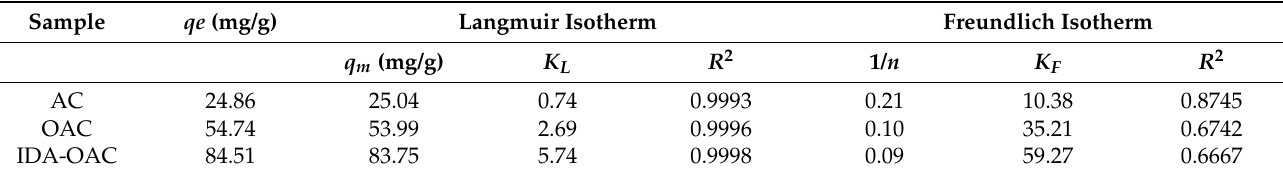
Table 3. The fitting results of Langmuir and Freundlich isotherm models.